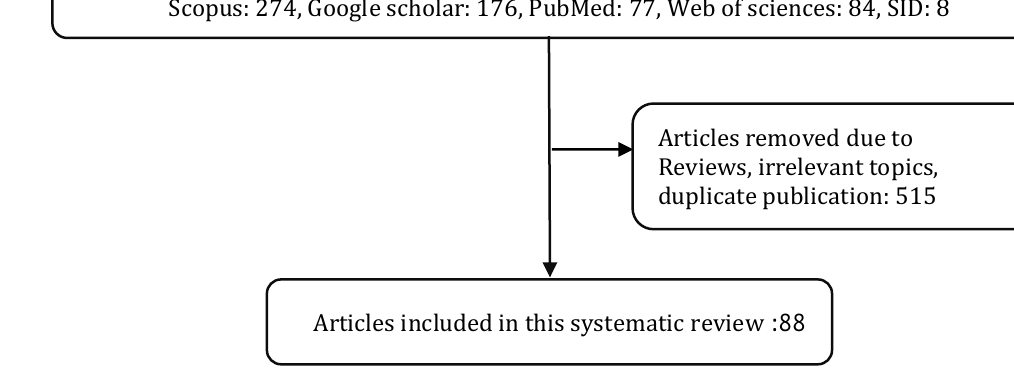
Figure 1. Flow chart for current systematic